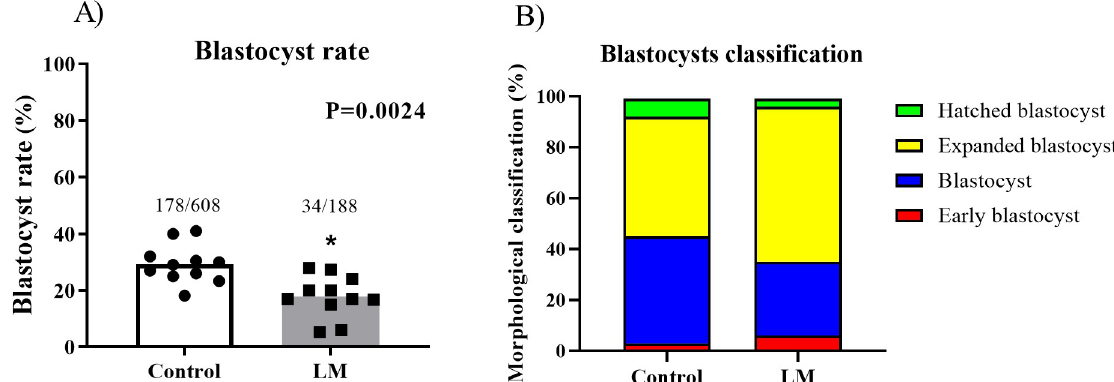
Fig 6. In vitro culture of presumptive zygotes. A) Total blastocysts rate obtained from the presumptive zygotes cultured for 7 days in conventional (control; 29.28%, 11 biological replicates) or in LM system (18.09%, 11 biological replicates). Statistics performed by chi square test, asterisk means statistical difference (P < 0.05). B) Blastocysts morphological classification Bo´ and Mapletoft (17), from the 11 different routines. Standard bars represents the SEM.